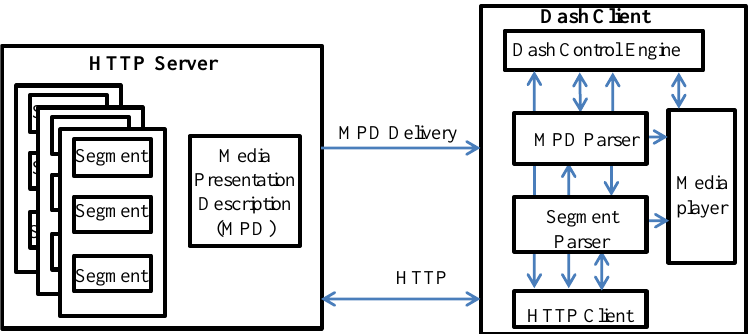
Figure 1. A simple MPEG-DASH streaming scenario.